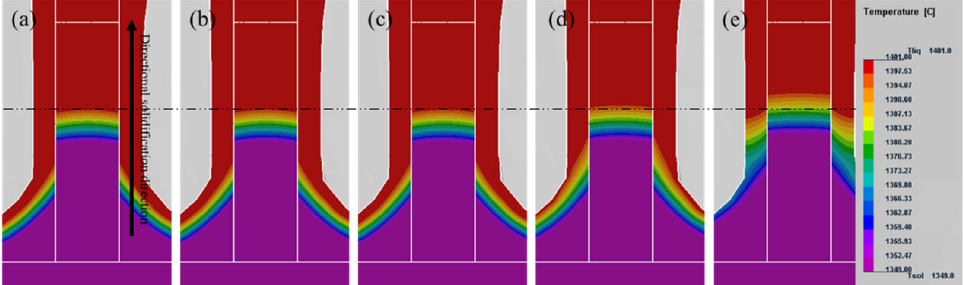
Figure 4. The thermal profile evolution in the melt ‐ back region at different times of moving the furnace body upward: ( a ) 0 s, ( b ) 25 s, ( c ) 50 s, ( d ) 75 s, ( e ) 125 s.